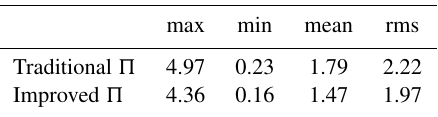
Table 3. PWV comparison in Hong Kong in February 2014 using traditional and improved conversion factors (mm).